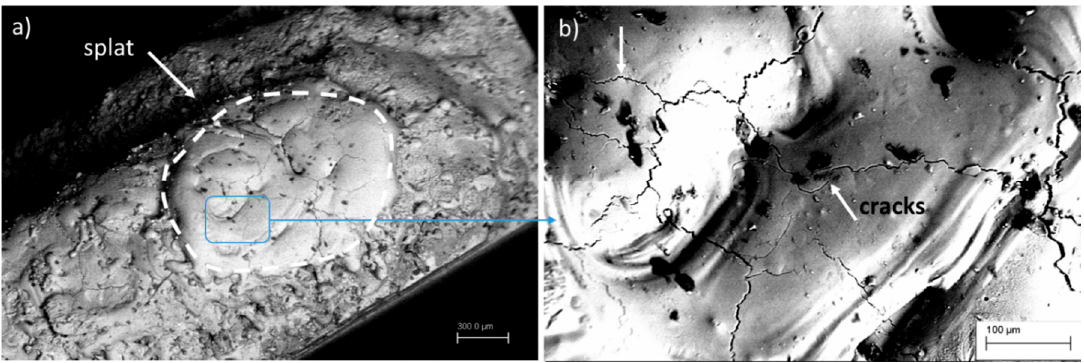
Figure 4. SEM micrograph of the AA2024 deposit surface following a manual ESD deposition: ( a ) morphology of 50 layer deposits in higher magnification; ( b ) enlarged image of the spot fringe at 500 × .